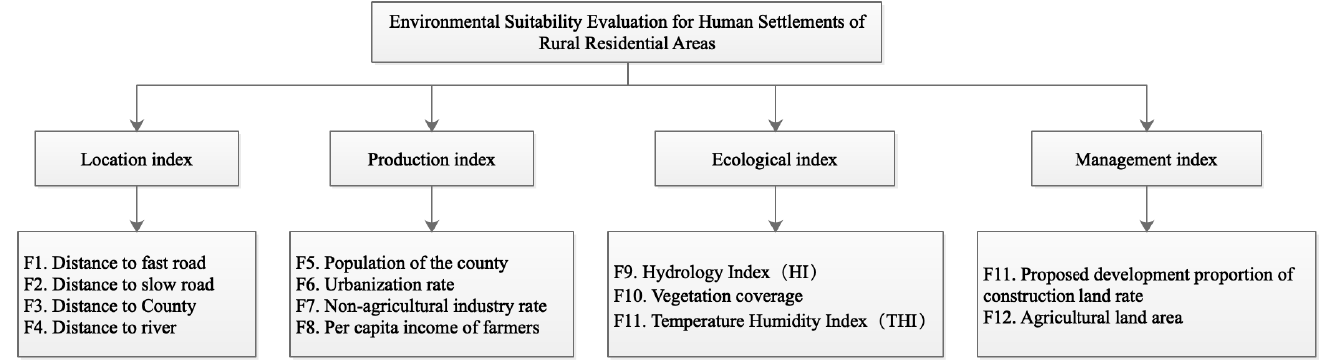
Figure 3. Evaluation index system of rural residential suitability. Table 2. Table of suitability evaluation